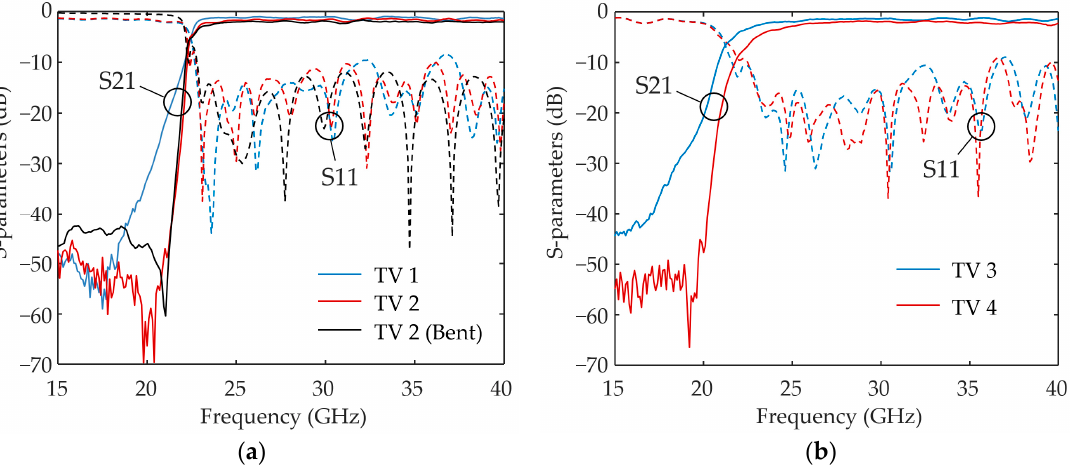
Figure 7. Measured results of S-parameters for ( a ) TV 1, TV 2, TV 2 (bent) (FMSIWs) and ( b ) TV 3 and TV 4